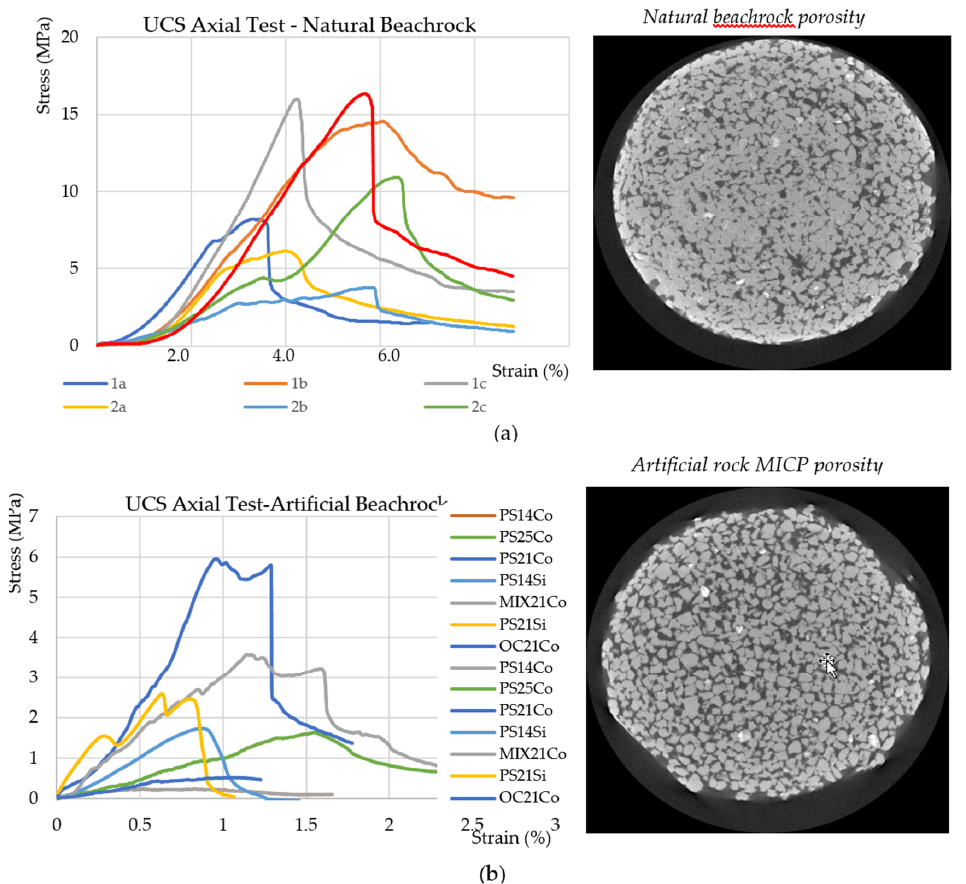
Figure 7. Comparison of the unconfined compressive strength (UCS) axial load between ( a ) natural beachrocks and ( b ) artificial rock based on the microbially induced carbonate precipitation (MICP) method with x-ray computed tomography (X-ray CT) scan images of porosity.